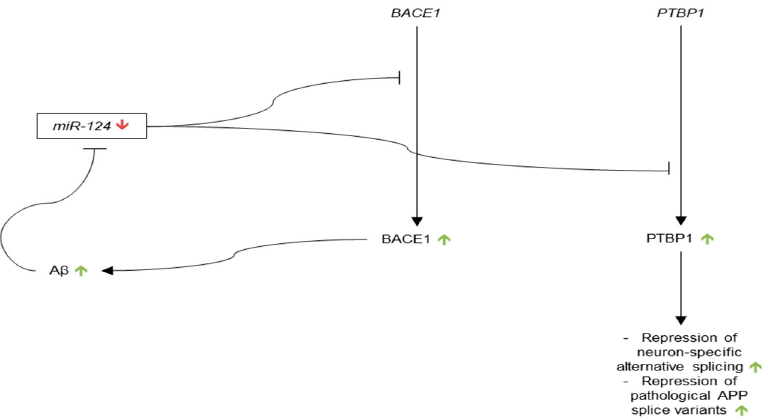
Figure 2. Regulation by microRNA (miR)-124. miR-124 inhibits the translation of BACE1 and Polypyrimidine Tract Binding Protein 1 (PTBP1). The down-regulation of miR-124 in AD brain is indicated by the red arrow. The hypothetical up-regulations of the target proteins and their cellular effects are denoted by the green arrows.